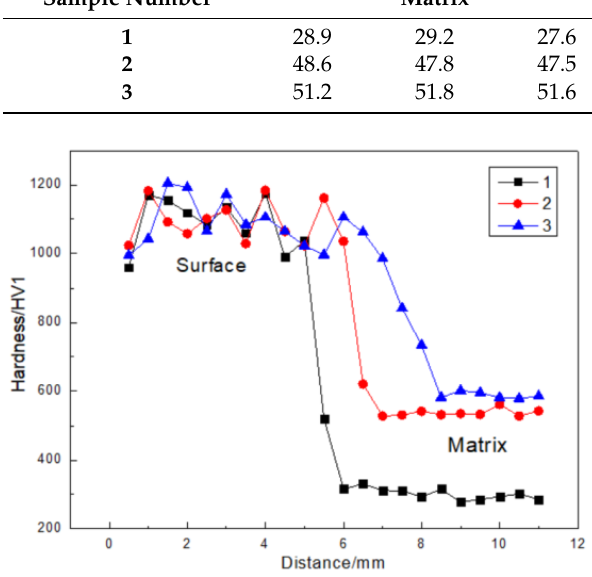
Figure 11. Vickers hardness curve of sample.